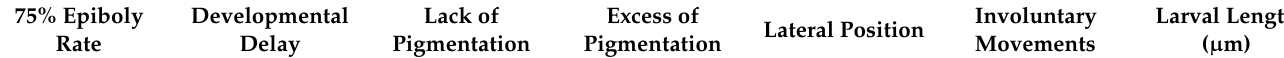
Involuntary Larval Length Movements ( µ